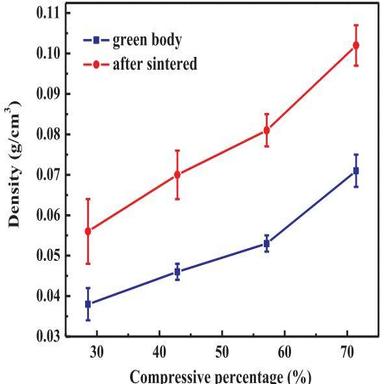
The bulk densities of PFMs under different compressive percentages before and after sintered.